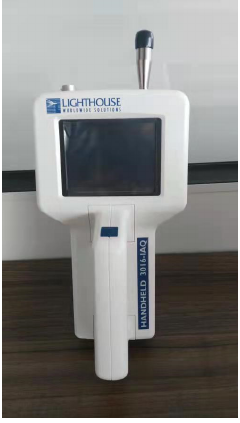
Figure 5. The particulate matter sampler.